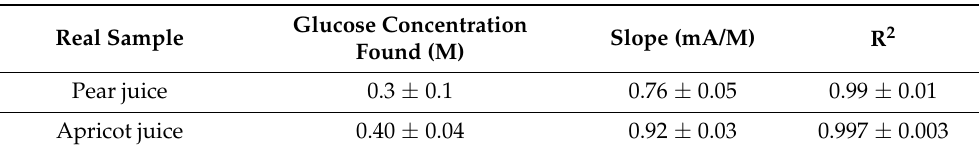
Figure 6. Effect of fructose (F), saccharose (S), and ascorbic acid (AA) on the current value in a 0.2 mM ( a ) and 2.0 mM ( b ) glucose (G) solution; the glucose:interferent ratios are equal to 1:1, 1:0.6, and 1:0.05, respectively.